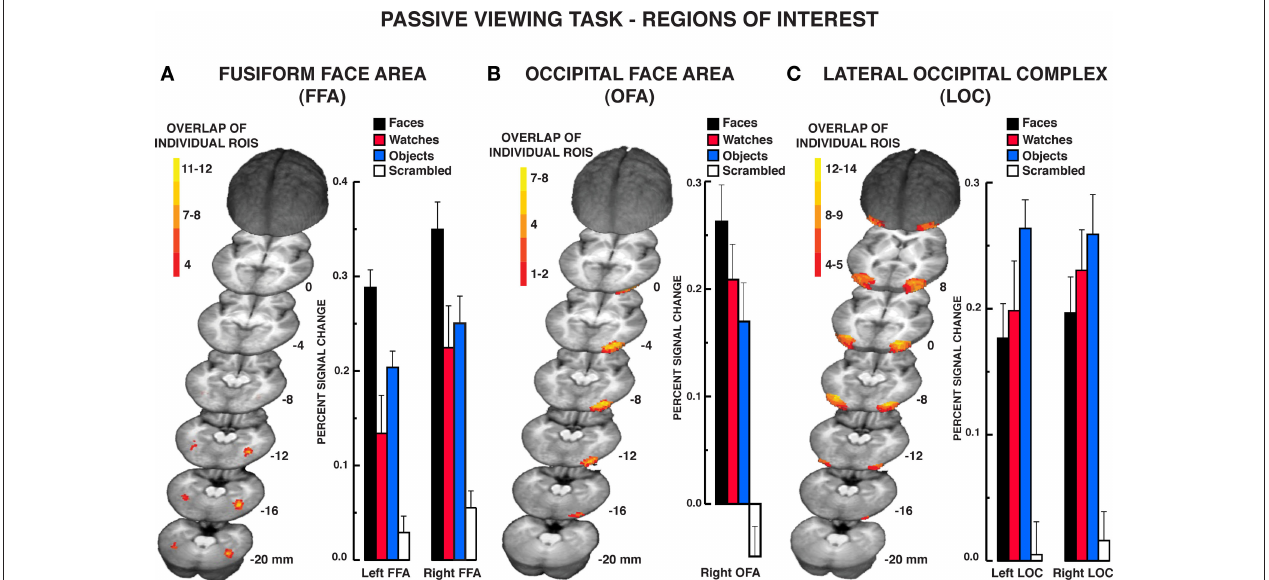
The left-hemisphere OFA is not shown as only 12 of the 17 participants produced a reliable left OFA. The location of the maximum overlap in the right OFA occurred at − 28, 86, − 10. Seven of the 15 participants included this location within their right OFA. (C) The LOC was defined as regions within the middle and inferior occipital gyri producing significantly greater activation to diverse objects relative to scrambled stimuli. The location of the maximum overlap in the rLOC occurred at − 30, − 81, − 4; 14 of 15 participants included this location within their rLOC. The location of the maximum overlap in the lLOC occurred at 35, − 70, − 7; 13 of 14 participants included this location within their lLOC. The bar graphs display the mean signal in the respective regions of interest. Error bars =